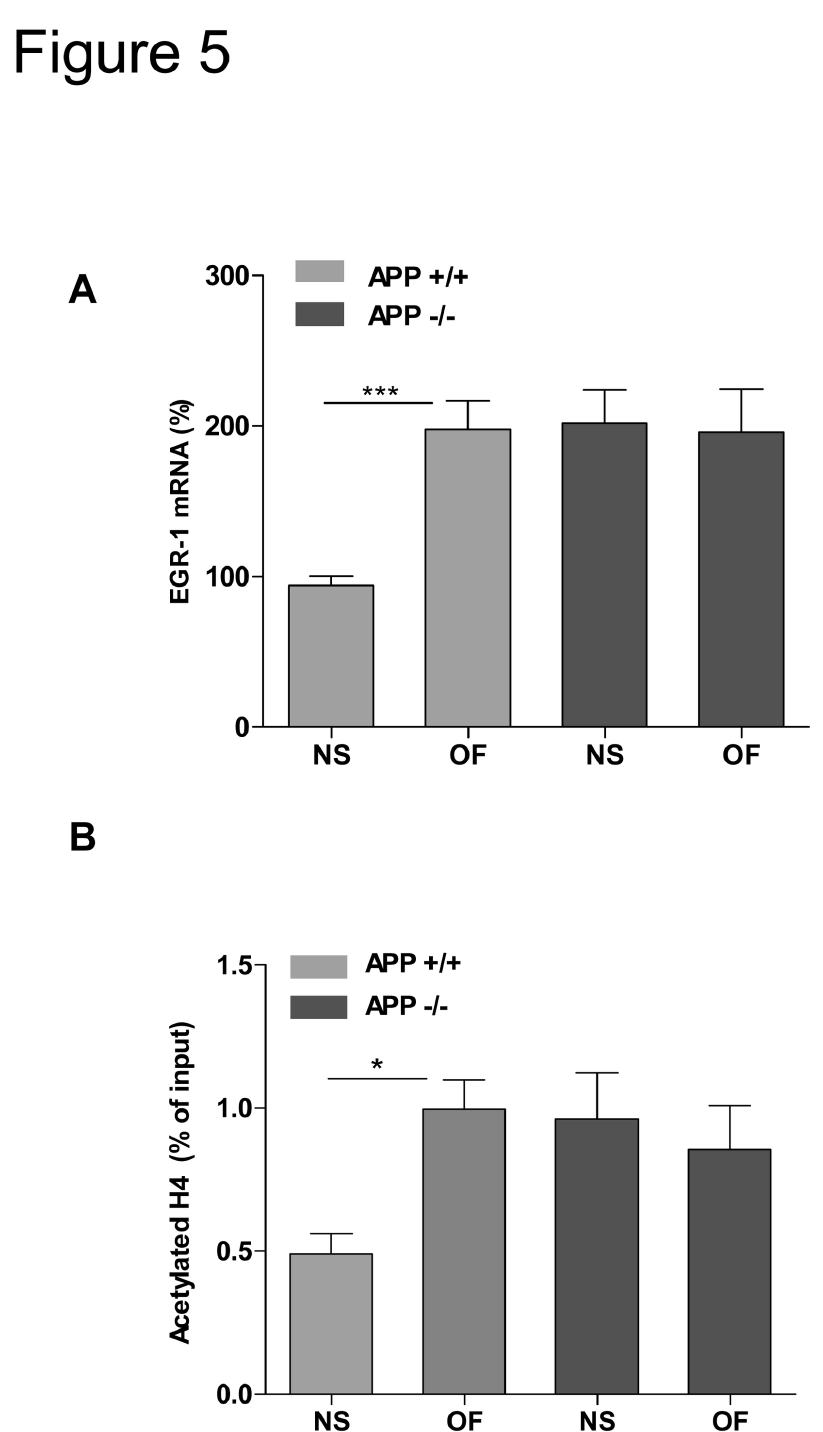
Figure 5. APP is needed to induce EGR-1 by novelty. A ) EGR-1mRNA levels were quantified by q-RT PCR in cortex of APP+/+ and APP-/- mouse exposed (OF) or not (not stimulated: NS) to the open field during 15 min (n=10). Values were normalized to the GAPDH mRNA, and expressed as percentage of the APP+/+ NS. One way Anova (***p<0.001) B ) Chromatin immunoprecipitations of EGR-1 promoter were performed on chromatin isolated from cerebral cortex APP +/+ and APP -/- mice exposed or not to novelty (n=7 per group) with normal IgG as negative control and anti-acetylated H4 antibody. Immunoprecipitated DNA was quantified by qPCR and normalized to the input. Two way Anova, *p<0.05. doi: 10.1371/journal.pone.0074305.g005 PLOS ONE |